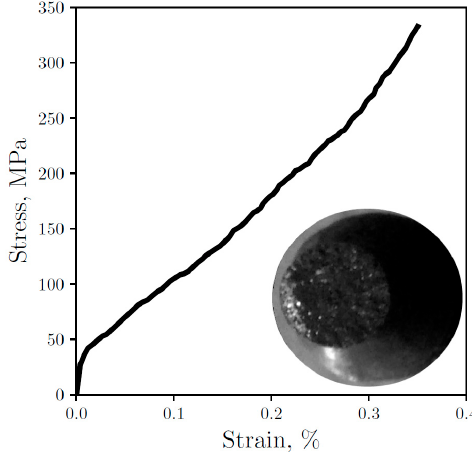
Figure 4. Experimental engineering stress-strain curve for the thimble sample with an image of the tested sample.